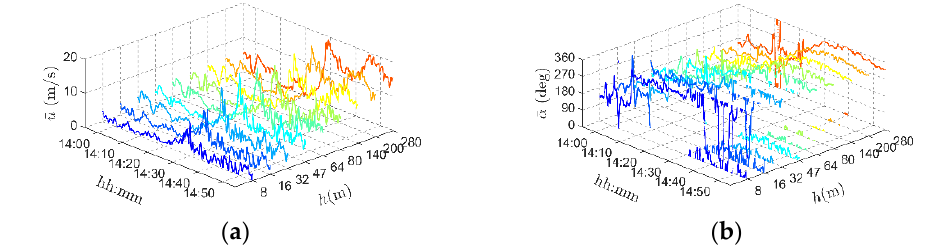
Figure 7. Slowly-varying mean wind speed ( a ) and direction ( b ) time history.